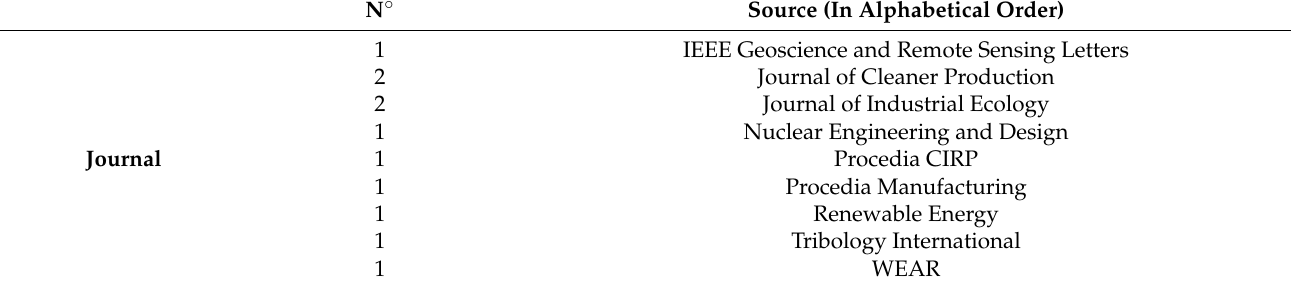
Table 2. Sources of journals and conference proceedings considered. N ◦ Source (In Alphabetical